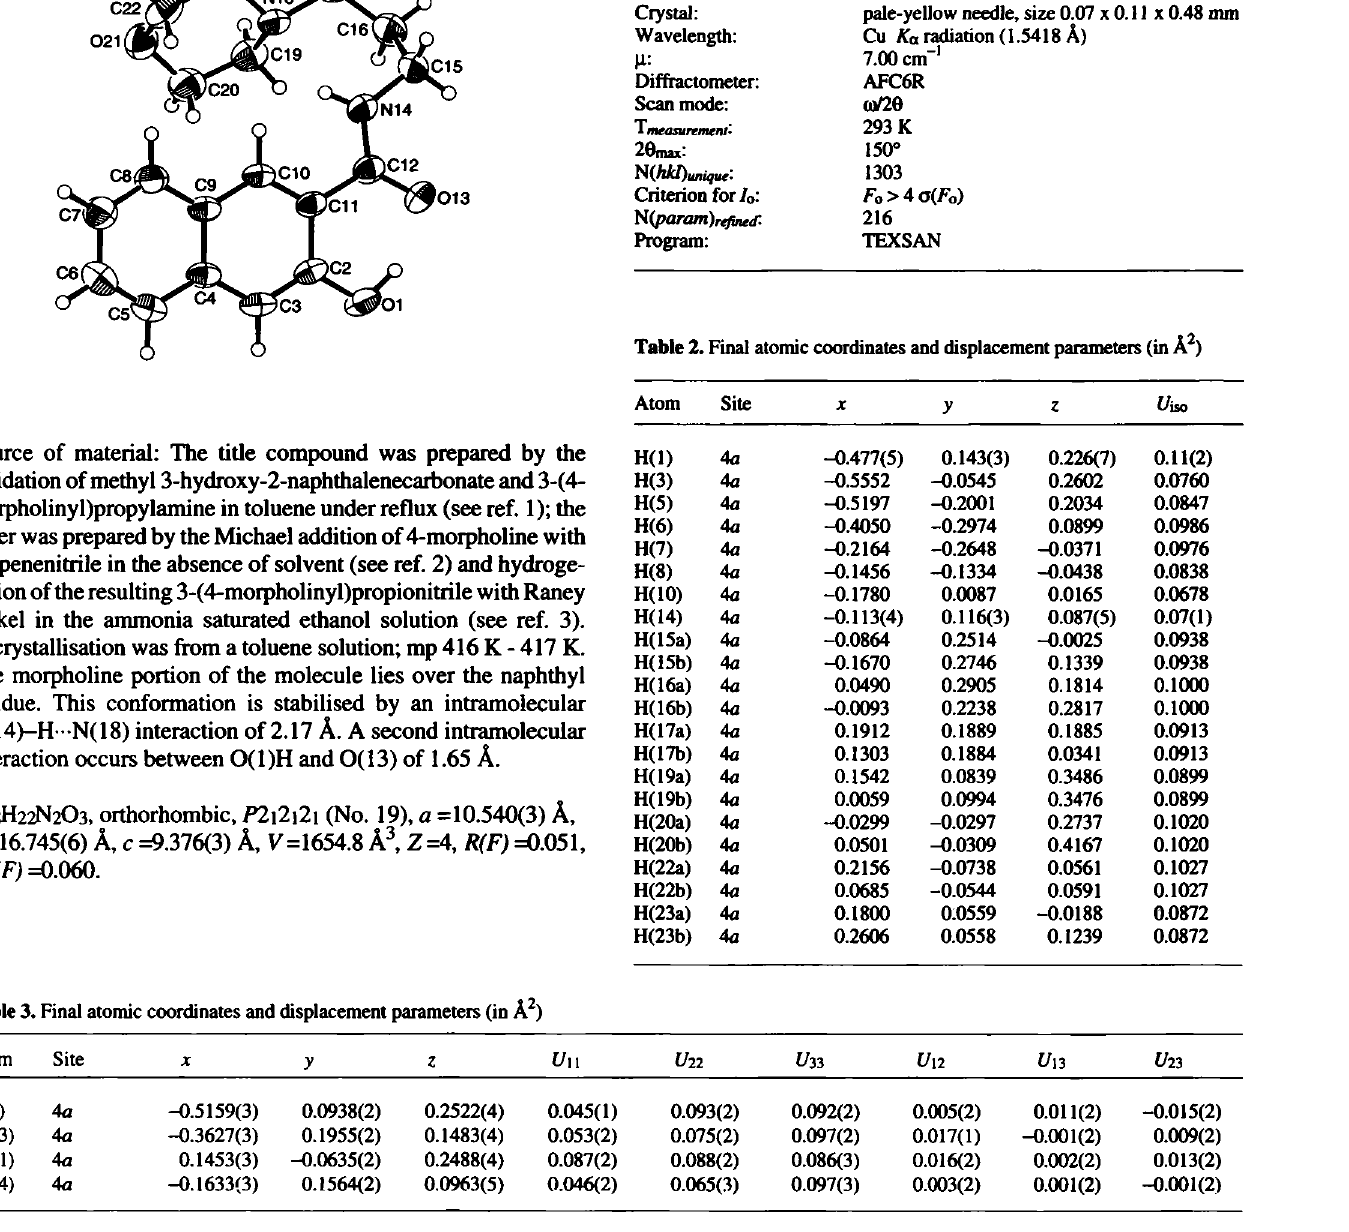
Table 1. Parameters used for the X-ray data collection